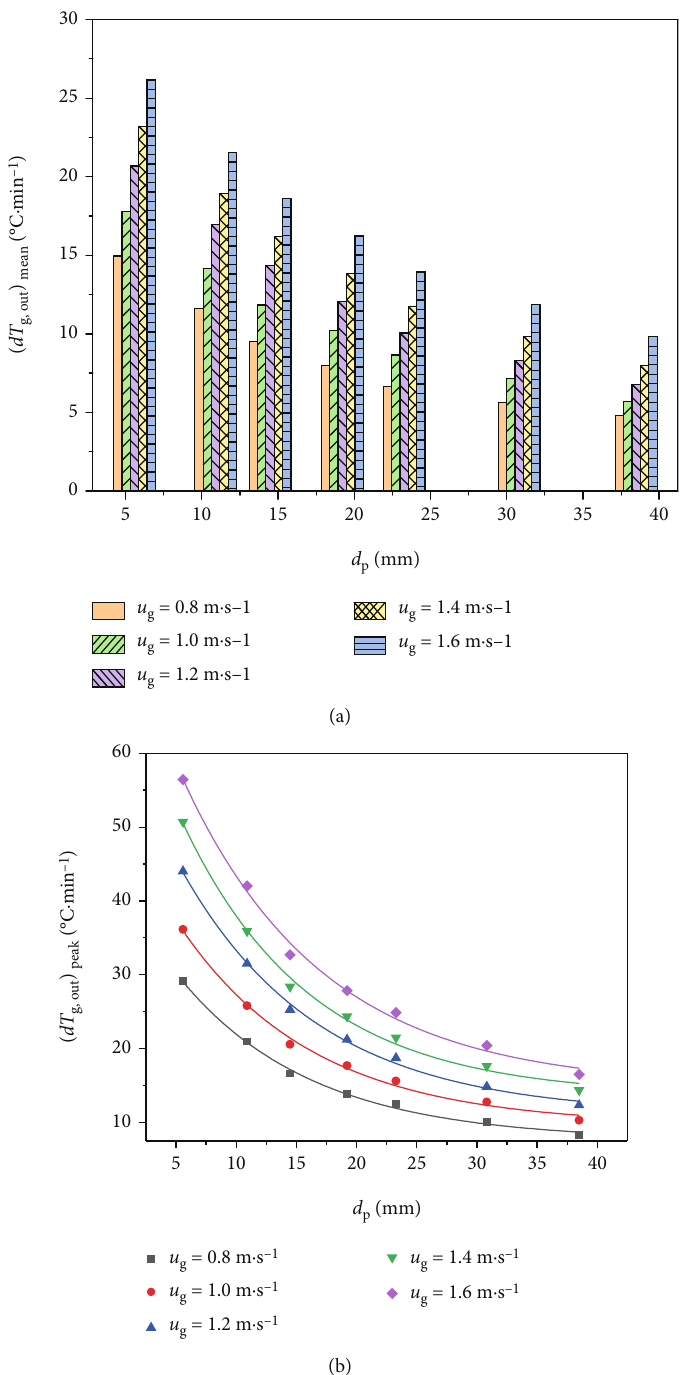
Figure 16: Change of the mean value ð dT equivalent particle diameter d